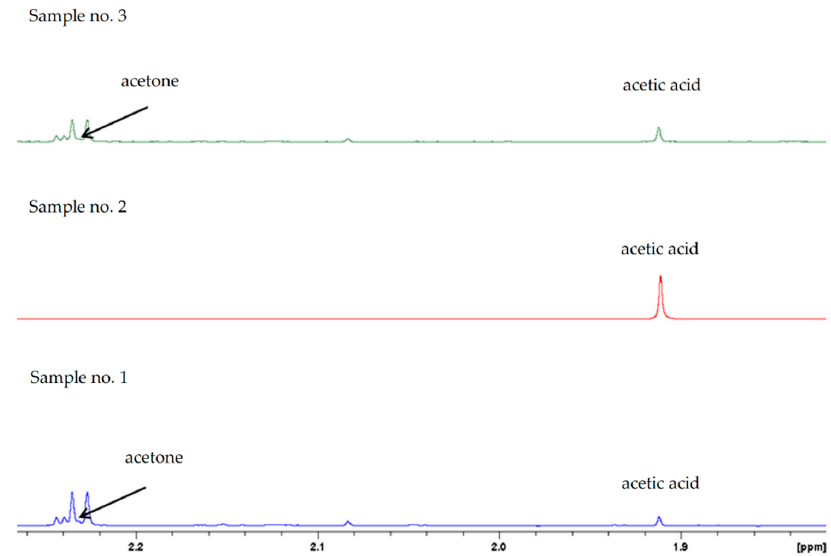
Figure 2. 1 H NMR spectra in the chemical shift region associated with acetone and acetic acid signals. (Sample no. 1—distillate obtained from mash inoculated with yeast; Sample no. 2—distillate obtained from mash inoculated with LAB; Sample no. 3—distillate obtained from mash inoculated with yeast and